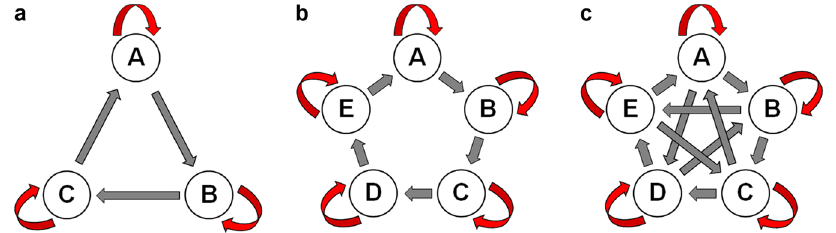
Figure 1. Cyclic games with intraspecific competitions. ( a ) Rock-paper-scissors (RPS) game of three species, ( b ) Extended Rock-Paper-Scissors (ERPS) game of five species, and ( c ) Rock-Paper-Scissors-Lizard-Spock (RPSLS) game of five species. Straight and looped arrows indicate interspecific and intraspecific competitions,